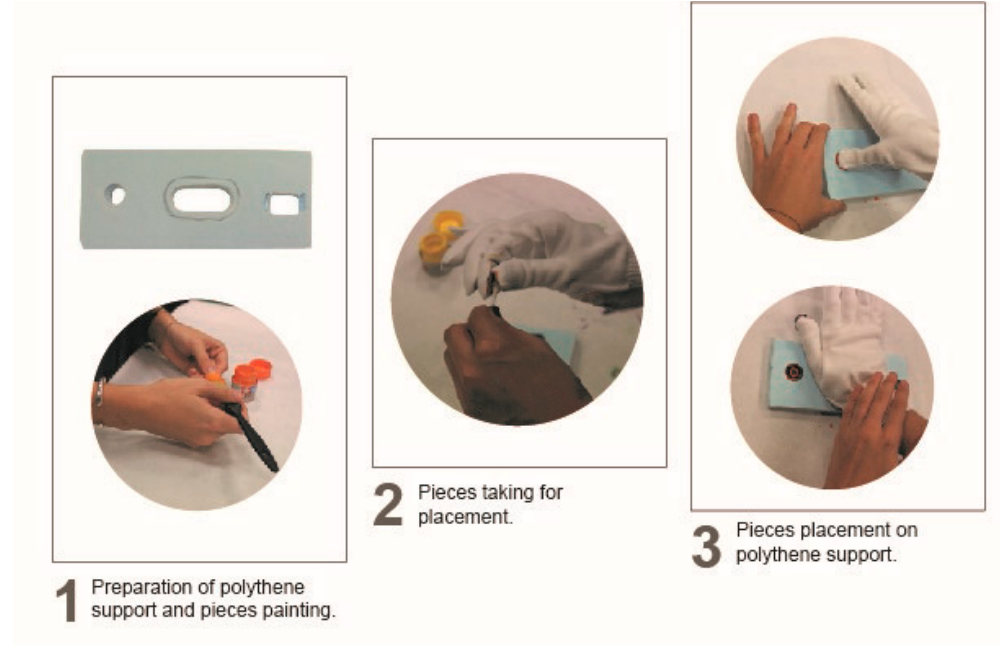
Figure 4. Sensor arrangement experiment.